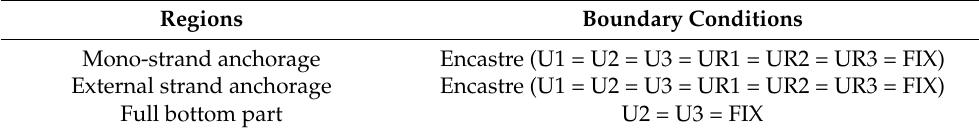
Table 3. Boundary condition.